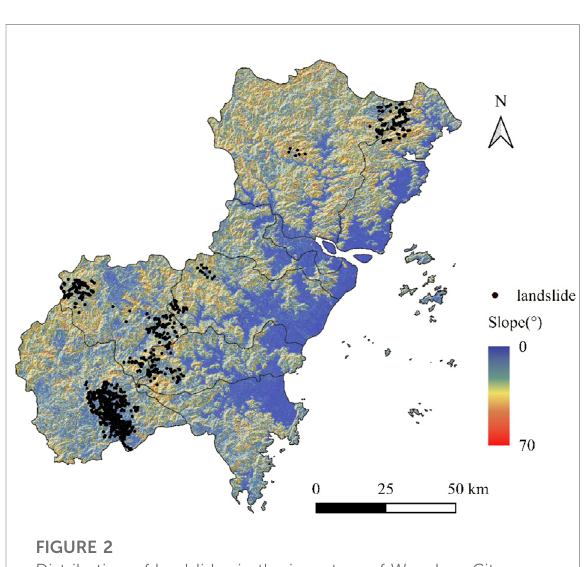
FIGURE 2 Distribution of landslides in the inventory of Wenzhou City. The base map is the slope map with 30-m